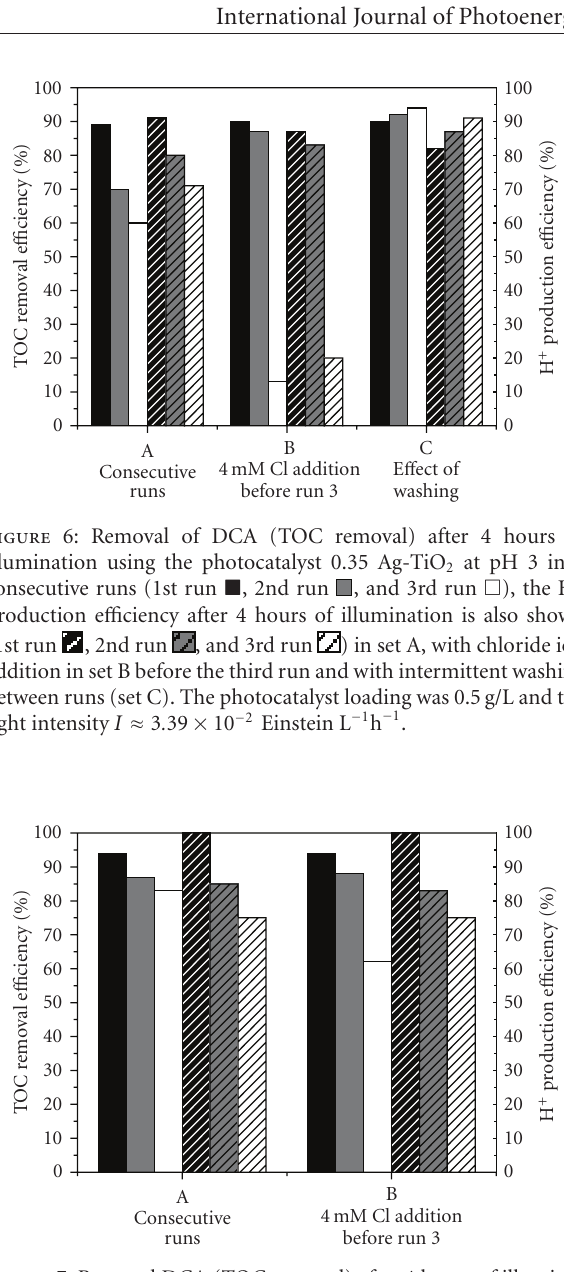
Figure 5: Removal of DCA (TOC removal) after 4 hours of illumination using the photocatalyst P25-TiO 2 at pH 3 in 3 consecutive runs (1st run (cid:2) , 2nd run , and 3rd run (cid:3) ), the H + production e ffi ciency after 4 hours of illumination is also shown (1st run , 2nd run , and 3rd run ) in set A, with chloride ion addition before the third run (set B), and with intermittent washing between runs (set C). The photocatalyst loading was 0.5 g/L and the light intensity I ≈ 3 . 39 × 10 − 2 Einstein L − 1 h − 1 .